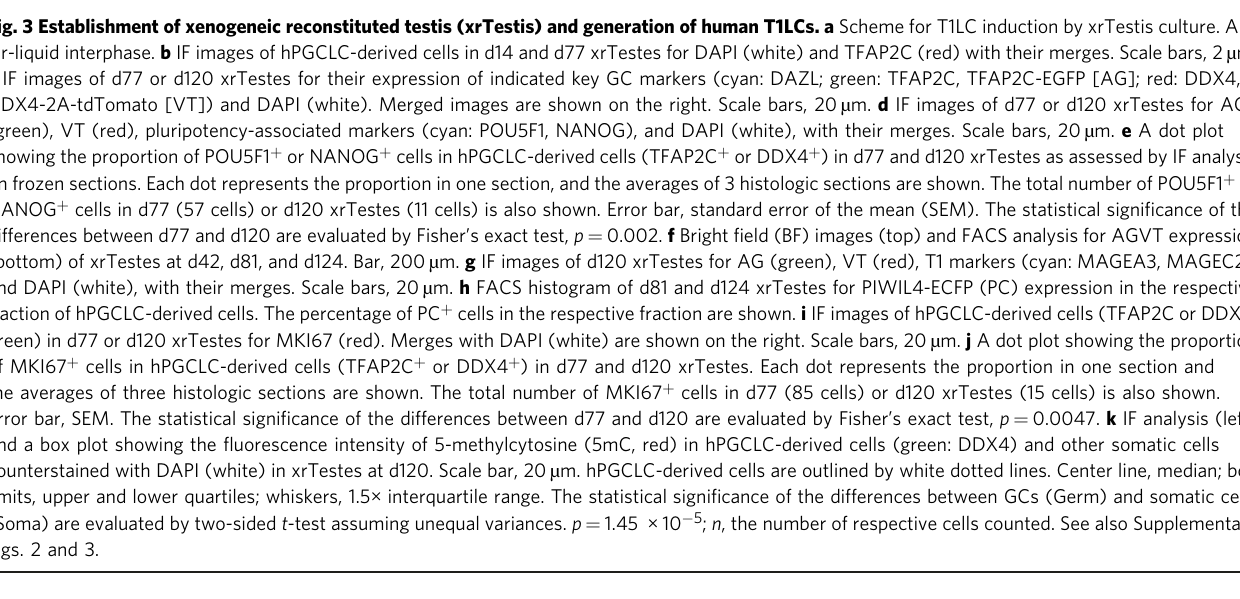
Fig. 3 Establishment of xenogeneic reconstituted testis (xrTestis) and generation of human T1LCs. a Scheme for T1LC induction by xrTestis culture. ALI, air-liquid interphase. b IF images of hPGCLC-derived cells in d14 and d77 xrTestes for DAPI (white) and TFAP2C (red) with their merges. Scale bars, 2 µ m. c IF images of d77 or d120 xrTestes for their expression of indicated key GC markers (cyan: DAZL; green: TFAP2C, TFAP2C-EGFP [AG]; red: DDX4, DDX4-2A-tdTomato [VT]) and DAPI (white). Merged images are shown on the right. Scale bars, 20 µ m. d IF images of d77 or d120 xrTestes for AG (green), VT (red), pluripotency-associated markers (cyan: POU5F1, NANOG), and DAPI (white), with their merges. Scale bars, 20 µ m. e A dot plot showing the proportion of POU5F1 + or NANOG + cells in hPGCLC-derived cells (TFAP2C + or DDX4 + ) in d77 and d120 xrTestes as assessed by IF analysis on frozen sections. Each dot represents the proportion in one section, and the averages of 3 histologic sections are shown. The total number of POU5F1 + or NANOG + cells in d77 (57 cells) or d120 xrTestes (11 cells) is also shown. Error bar, standard error of the mean (SEM). The statistical signi fi cance of the differences between d77 and d120 are evaluated by Fisher ’ s exact test, p = 0.002. f Bright fi eld (BF) images (top) and FACS analysis for AGVT expression (bottom) of xrTestes at d42, d81, and d124. Bar, 200 µ m. g IF images of d120 xrTestes for AG (green), VT (red), T1 markers (cyan: MAGEA3, MAGEC2), and DAPI (white), with their merges. Scale bars, 20 µ m. h FACS histogram of d81 and d124 xrTestes for PIWIL4-ECFP (PC) expression in the respective fraction of hPGCLC-derived cells. The percentage of PC + cells in the respective fraction are shown. i IF images of hPGCLC-derived cells (TFAP2C or DDX4, green) in d77 or d120 xrTestes for MKI67 (red). Merges with DAPI (white) are shown on the right. Scale bars, 20 µ m. j A dot plot showing the proportion of MKI67 + cells in hPGCLC-derived cells (TFAP2C + or DDX4 + ) in d77 and d120 xrTestes. Each dot represents the proportion in one section and the averages of three histologic sections are shown. The total number of MKI67 + cells in d77 (85 cells) or d120 xrTestes (15 cells) is also shown. Error bar, SEM. The statistical signi fi cance of the differences between d77 and d120 are evaluated by Fisher ’ s exact test, p = 0.0047. k IF analysis (left) and a box plot showing the fl uorescence intensity of 5-methylcytosine (5mC, red) in hPGCLC-derived cells (green: DDX4) and other somatic cells counterstained with DAPI (white) in xrTestes at d120. Scale bar, 20 µ m. hPGCLC-derived cells are outlined by white dotted lines. Center line, median; box limits, upper and lower quartiles; whiskers, 1.5× interquartile range. The statistical signi fi cance of the differences between GCs (Germ) and somatic cells (Soma) are evaluated by two-sided t -test assuming unequal variances. p = 1.45 × 10 − 5 ; n , the number of respective cells counted. See also Supplementary Figs. 2 and